Question: What visual encoding does this figure use to show its data?
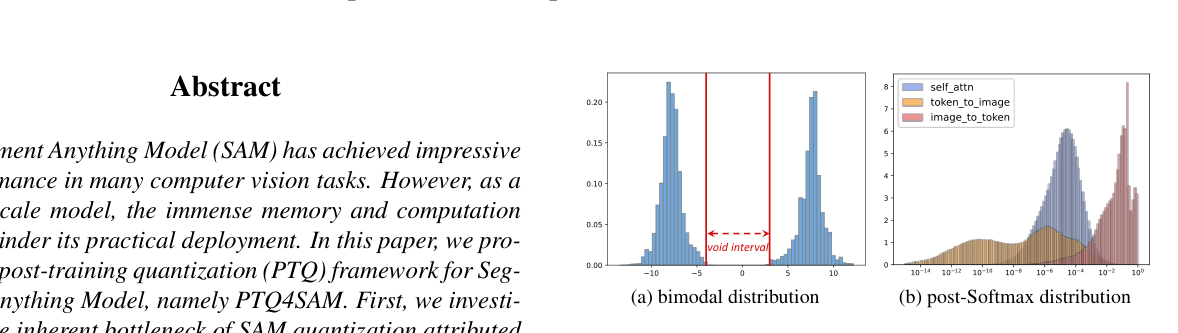
Answer: histogram